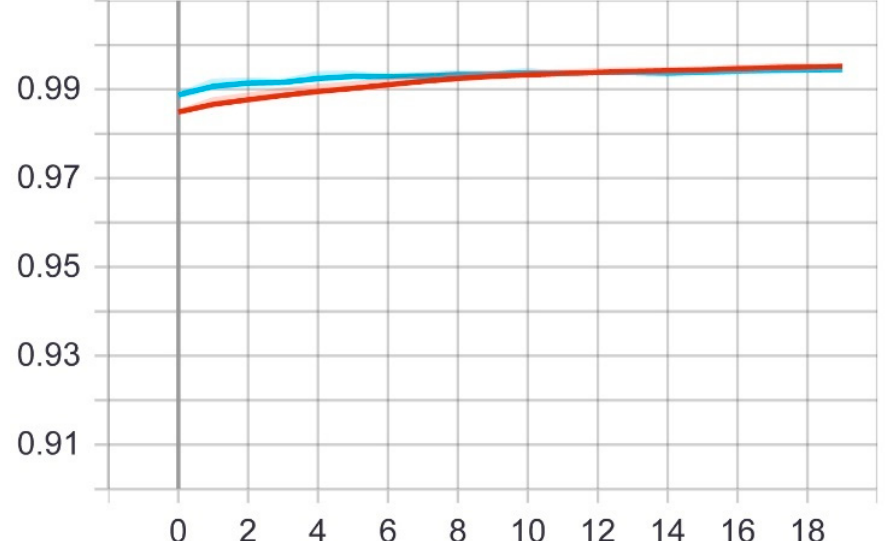
Figure 5. Accuracy (red line) and validation (blue line) convergence curves of the first model over 20 epochs.